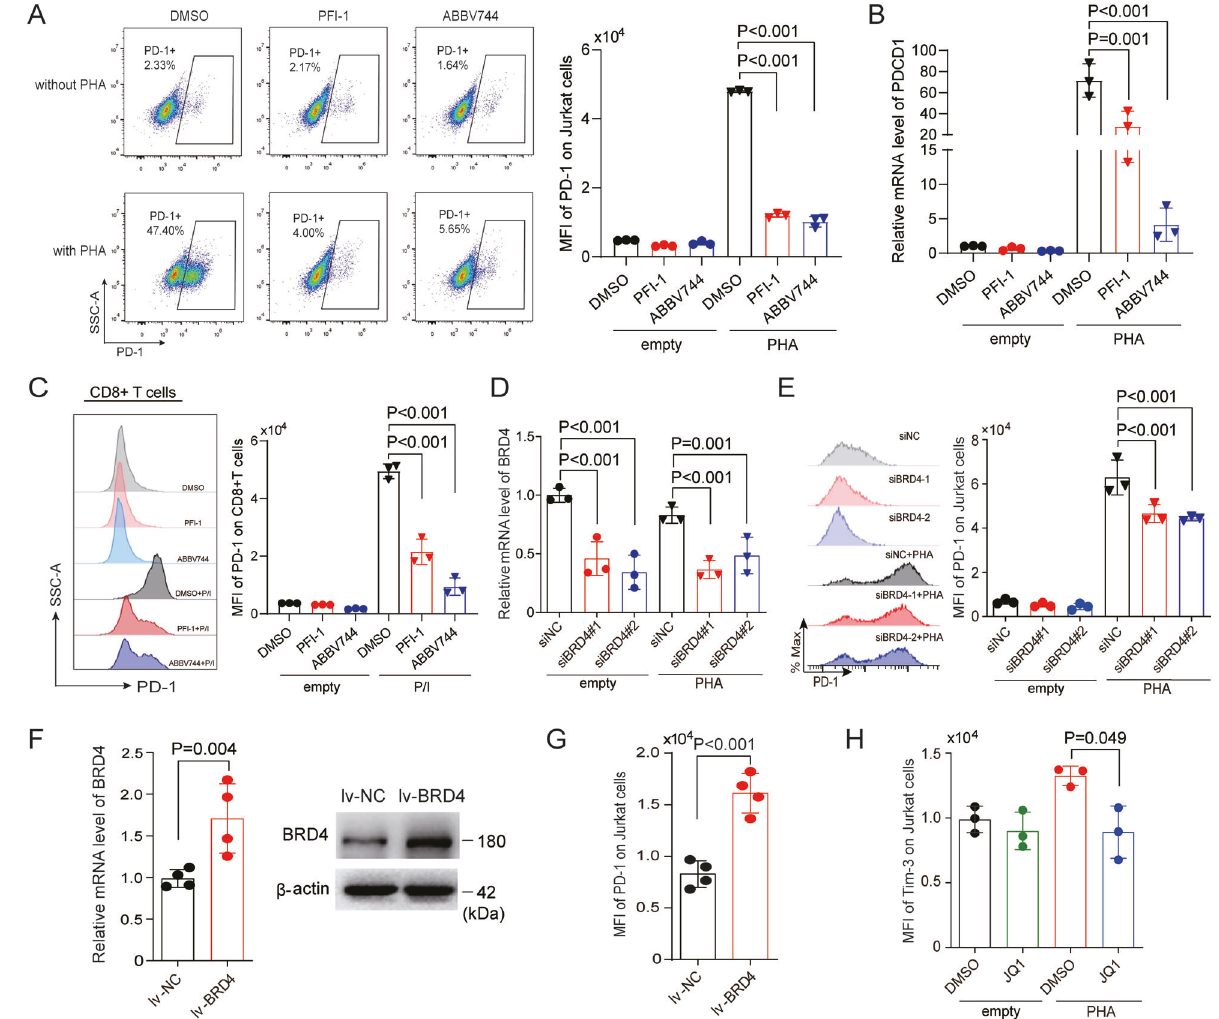
Fig. 2 BRD4 inhibition suppresses the expression of PD-1 and Tim-3. A Jurkat cells stimulated with or without PHA (150 ng/mL) were treated with the BET inhibitors PFI-1 (5 μ M) and ABBV-744 (2 μ M) for 24 h, then PD-1 expression was determined by fl ow cytometry ( n = 3). B Jurkat cells stimulated with or without PHA (150 ng/mL) were treated with the BET inhibitors PFI-1 (5 μ M) and ABBV-744 (2 μ M) for 24 h, then PD-1 expression was determined by qRT-PCR ( n = 3). C Similar to Jurkat cells, CD8 + T cells were administrated with PFI-1 (5 μ M), and ABBV- 744 (2 μ M) for 24 h stimulated with or without P/I, and PD-1 expression was determined by FACS ( n = 3). D After Jurkat cells were stimulated with and without 150 ng/mL PHA after BRD4 knockdown by siRNA, BRD4 expression was examined by qRT-PCR ( n = 3). E After Jurkat cells were stimulated with and without 150 ng/mL PHA after BRD4 knockdown by siRNA, PD-1 expression was determined by FACS ( n = 3). F Jurkat cells were transfected by BRD4 overexpression lentivirus, then BRD4 expression was examined by qRT-PCR ( n = 4) and western blot. G PD-1 expression of Jurkat cells was detected by FACS after BRD4 overexpression lentivirus was transfected ( n = 4). H Jurkat cells were treated with 0.5 μ M JQ1 for 24 h in the presence and absence of PHA (150 ng/mL), then the expression of Tim-3 was examined by FACS ( n = 3). Data in ( A – H ) are expressed as mean ± SD. n = 3 or more independent biological replicates, presented as individual points. For western blot, similar results were obtained for three independent biological experiments. P value < 0.05 was considered to be signi fi cant ( A – E , H : one-way ANOVA with Bonferroni post hoc test; F , G : two-tailed unpaired Student ’ s t